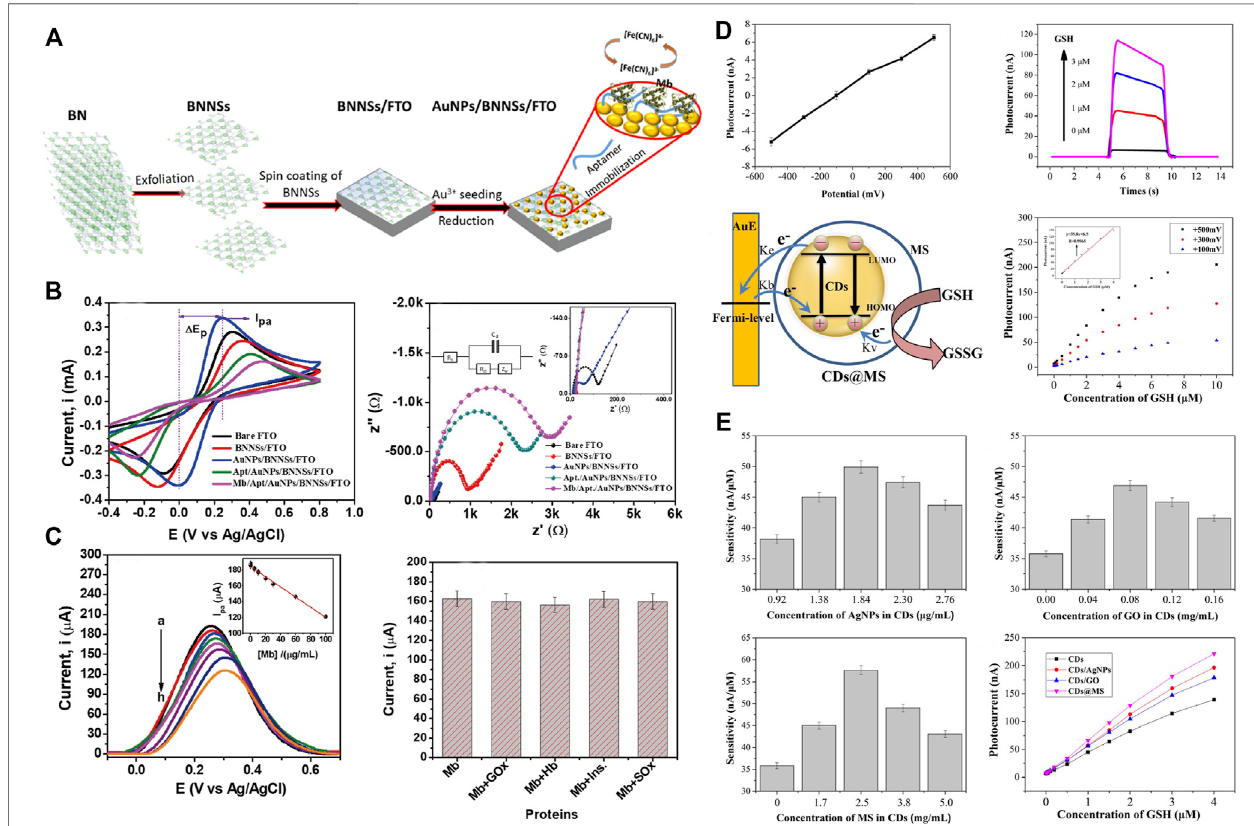
FIGURE 7 | Nano-biosensor based on electrochemical or photoelectrochemical for the detection of MI-related indicators. (A) Schematic illustration for the fabrication processes of the AuNPs/BNNSs nanosheets and the detection of myoglobin (Mb). (B) Electrochemical characterization of AuNPs/BNNSs nanosheets. (C) Detection of Mb and interference studies, stability, reproducibility, and real-sample analyses of AuNPs/BNNSs nanosheets. Adapted with permission from Adeel et al., 2019. (D) The mechanism of the carbon dots nano-biosensor based on photoelectrochemical for the detection of glutathione (GSH). (E) Sensitivity and photocurrentsthecarbondots-basedbiosensorsintroducingsilvernanoparticles,grapheneoxide,andmesoporoussilica.AdaptedwithpermissionfromLietal.,2018.